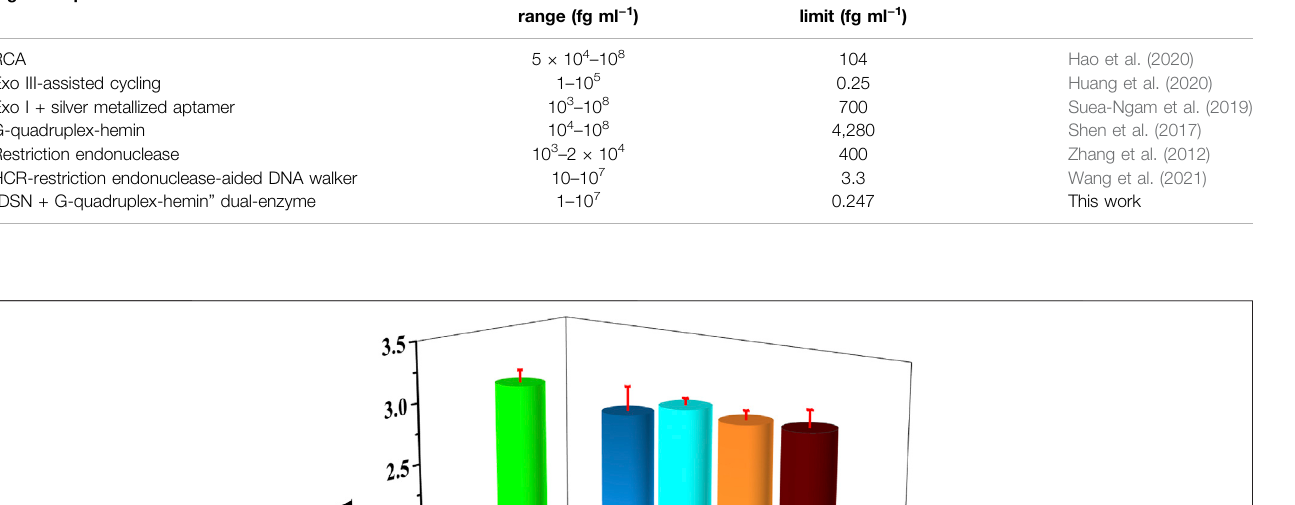
TABLE 2 | Comparisons of analytical performances of different OTA aptasensors Signal ampli fi cation mode